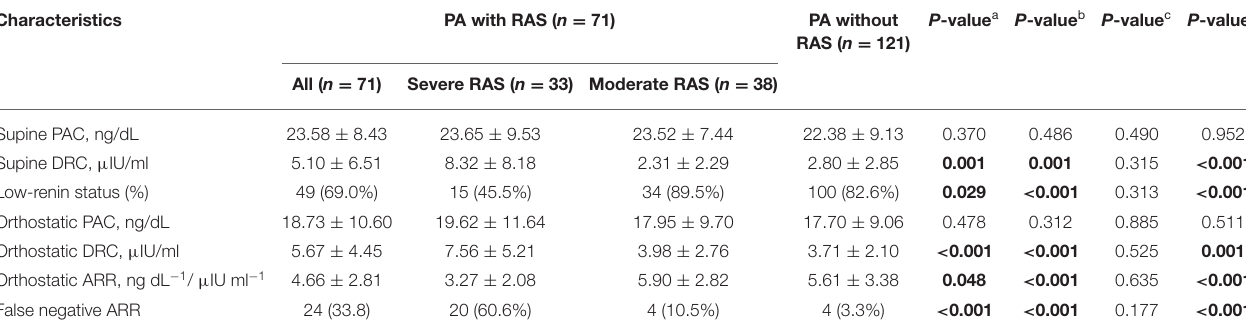
P-values less than 0.05 are shown in bold in the table. a comparison between the PA with RAS group and PA without RAS group; b comparison between patients with severe RAS in the PA with RAS group and patients in the PA without RAS group; c comparison between patients with moderate RAS in the PA with RAS group and patients in the PA without RAS group; d comparison of patients with severe RAS and moderate RAS in the PA with RAS group.